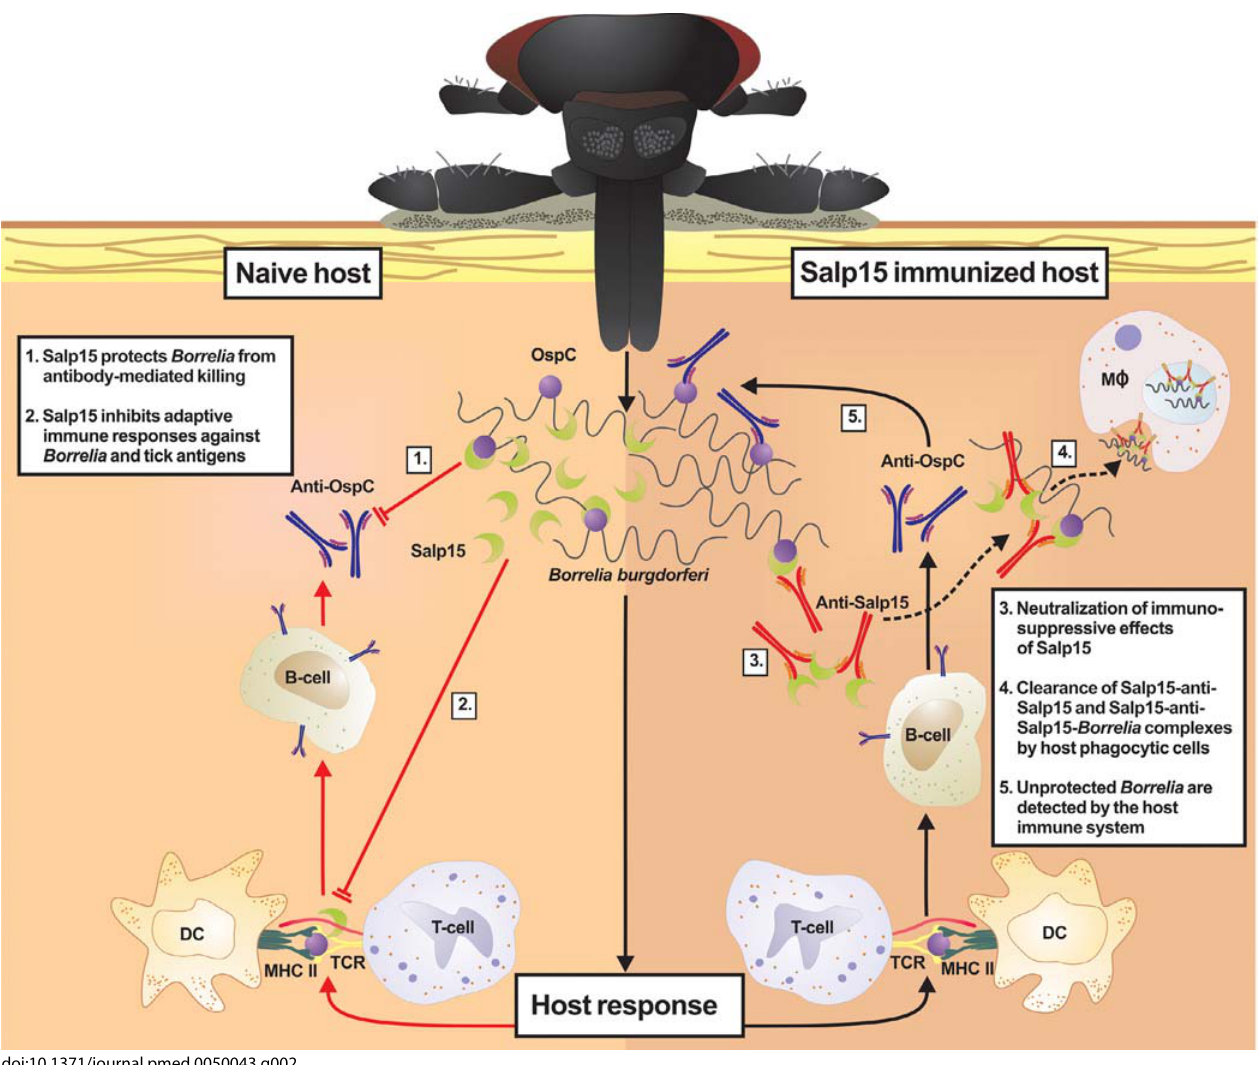
Figure 2. Diagram Showing How an Anti-Salp15 Vaccine Could Prevent Transmission of B. burgdorferi During tick feeding and early mammalian infection, B. burgdorferi expresses OspC, which binds to Salp15 in tick saliva. This binding acts as a shield and protects the spirochete from killing by the host. In addition, Salp15 has been shown to directly inhibit dendritic cell and T cell activation, which could facilitate tick feeding. Salp15 antibodies are likely to bind to Salp15 that has previously bound to OspC on the surface of B. burgdorferi in the tick salivary gland and could thereby enhance clearance by host phagocytic immune cells. Obviously, the Salp15 antibodies would need to recognize a Salp15 epitope other than the epitope that is required for binding of Salp15 to OspC. Similarly, if anti-Salp15 antibodies were to bind to free Salp15, they could neutralize the immunosuppressive effects of Salp15, which could hamper tick feeding and thereby transmission of B. burgdorferi from the tick to the host. Lastly, if anti-Salp15 antibodies were to inhibit binding of Salp15 to Borrelia OspC, this would render the spirochete susceptible to pre-existing or newly generated immunoglobulins. Importantly, Salp15 was originally identified by screening of a tick salivary gland cDNA expression library with tick immune rabbit sera, suggesting that antibodies against Salp15 may participate in tick rejection. DC, dendritic cell; MHC, major histocompatibility complex; MΦ, macrophage; TCR, T cell